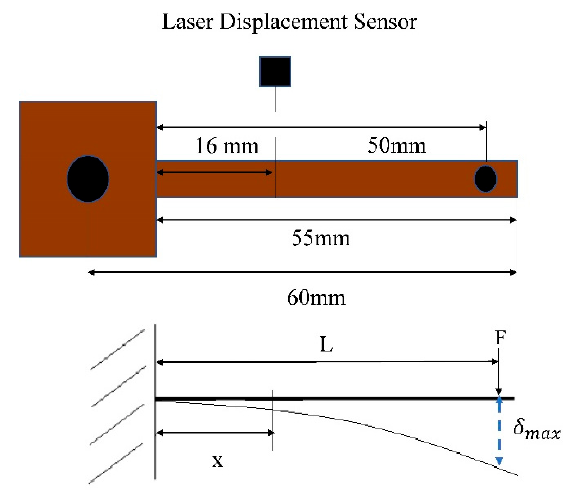
Figure 13. Experimental deflection of beam for different input currents.